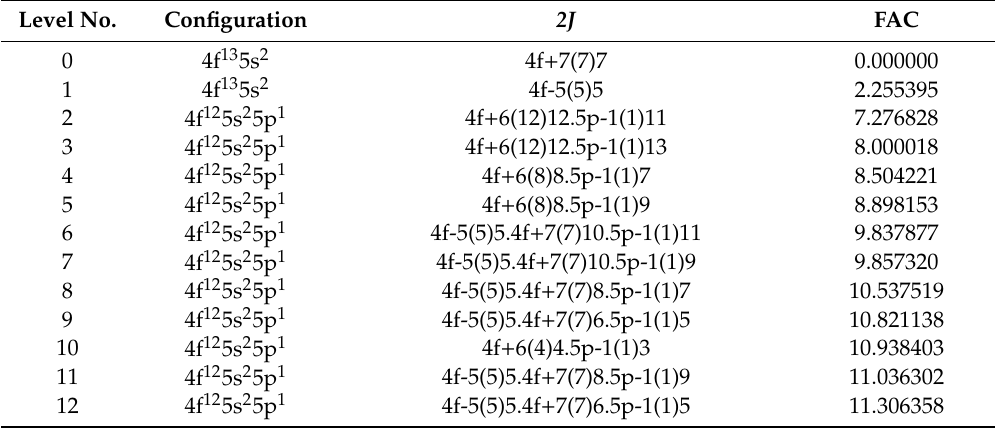
Table 10. Energy levels (in eV) for the lowest 500 levels calculated with FAC using INPF configurations for Pm-like W. Level